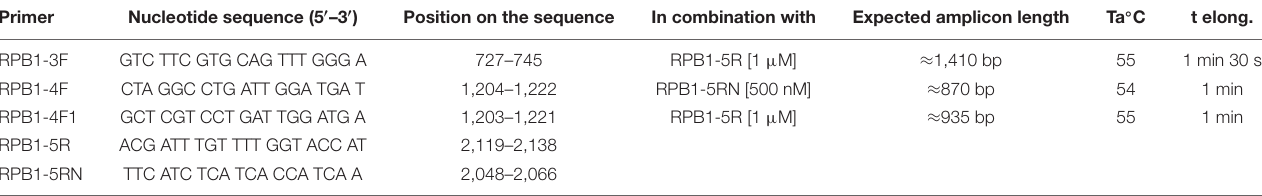
TABLE 1 | Primers characteristics and PCR conditions used for the amplification of the rpb1 sequences. Primer Nucleotide sequence (5 (cid:48) –3 (cid:48)